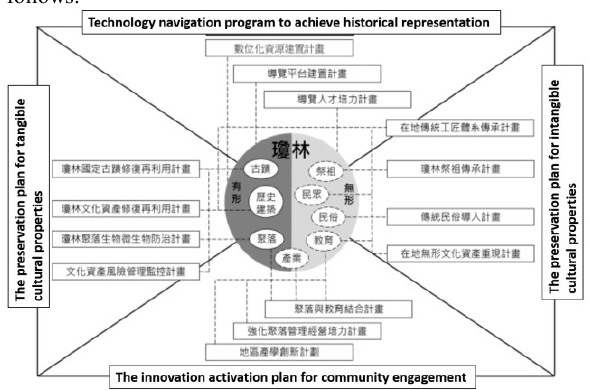
Figure 1. The relationship diagram for execution of this project